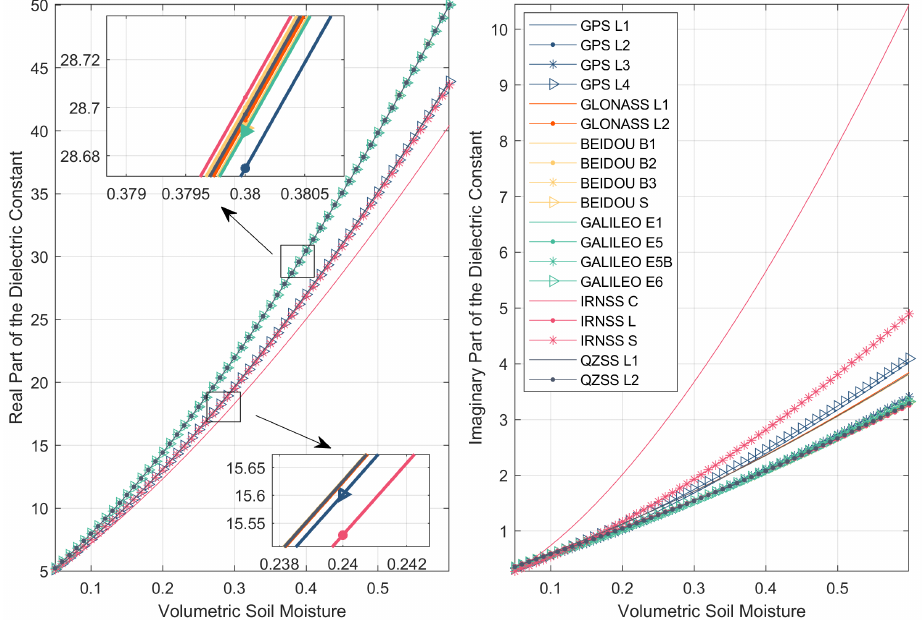
Figure 1. Real part ( left ) and imaginary part ( right ) of the dielectric constants versus the volumetric soil moisture at different GNSS frequency bands.